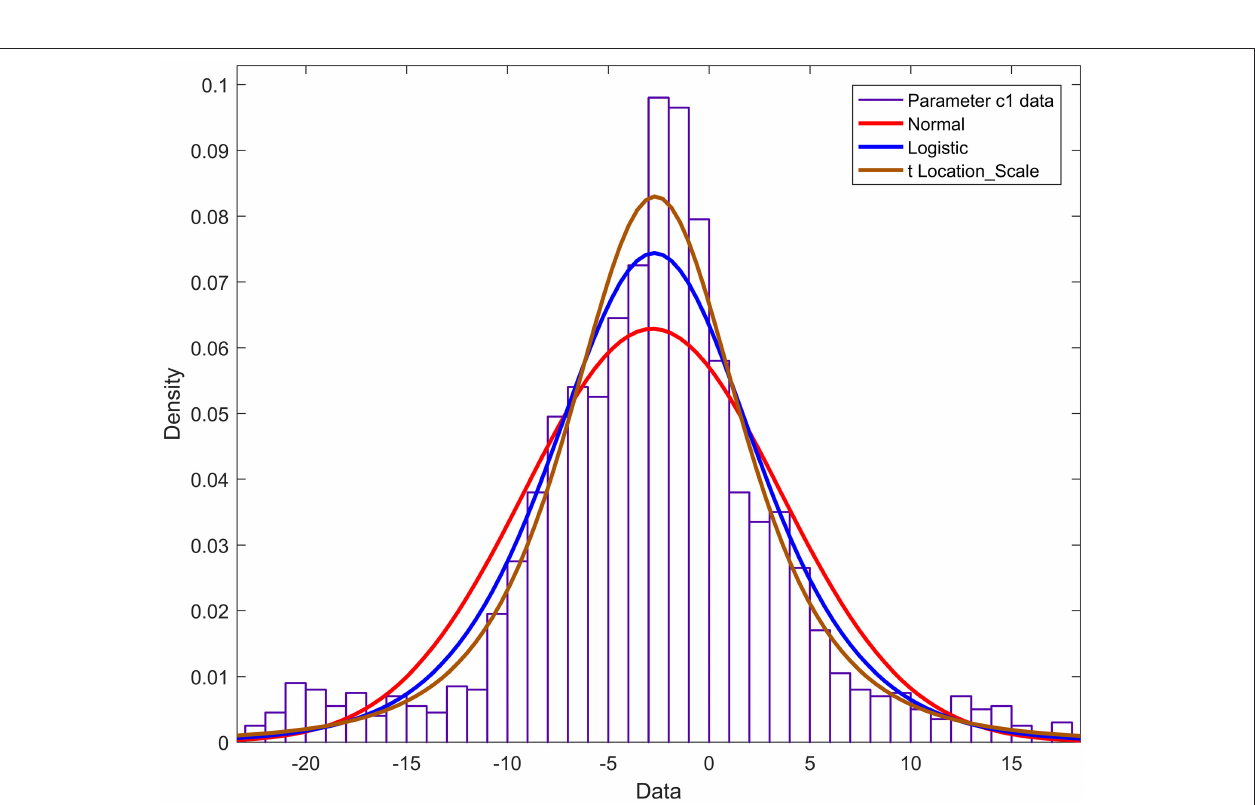
FIGURE 8 | Histogram and probability density function of parameter